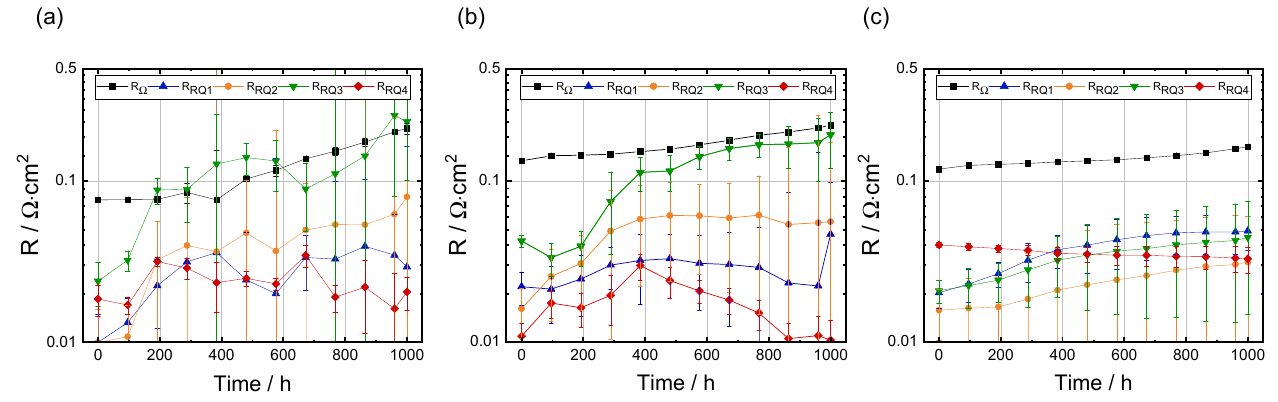
Figure 7. Individual resistance analysis for intermitted EIS at OCV from 0 h to 1000 h with 9 L · h − 1 fuel consisting of ( a ) 50% H 2 + 50% H 2 O at 800 °C, ( b ) 50% H 2 + 50% H 2 O at 750 °C, ( c ) 40% H 2 O + 40% CO 2 + 20% H 2 at 800 °C.